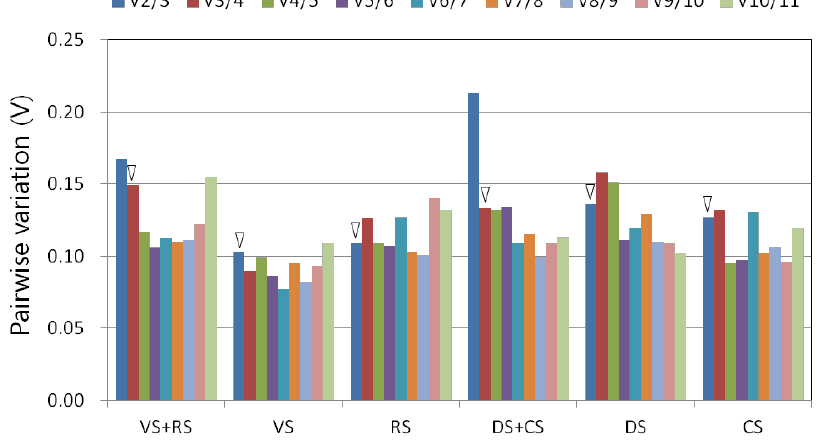
Figure 3. Pairwise variation ( V ) analysis by qBase PLUS to determine the optimal number of reference genes needed for accurate normalization in all the tested samples. V values less than 0.15 indicate that no additional genes are needed to calculate a reliable normalization factor. The triangles indicate V values lower than 0.15. CS, cold stress; DS, desiccation stress; RS, reproductive stage; VS, vegetative